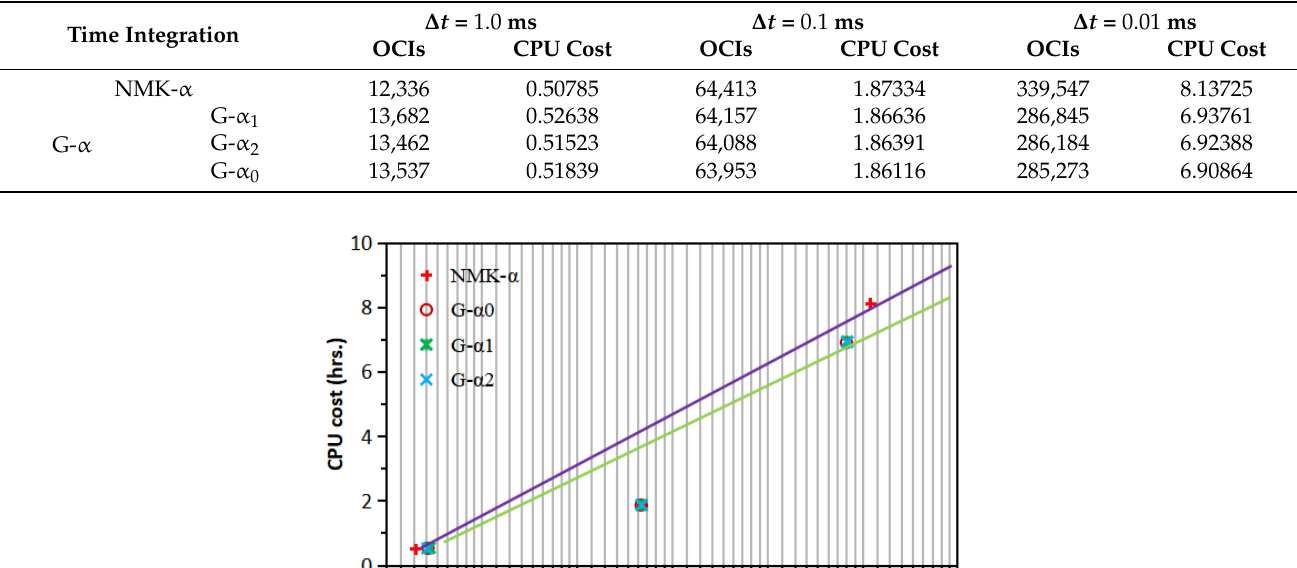
Table 4. Comparisons of CPU cost and OCIs between the referred schemes.